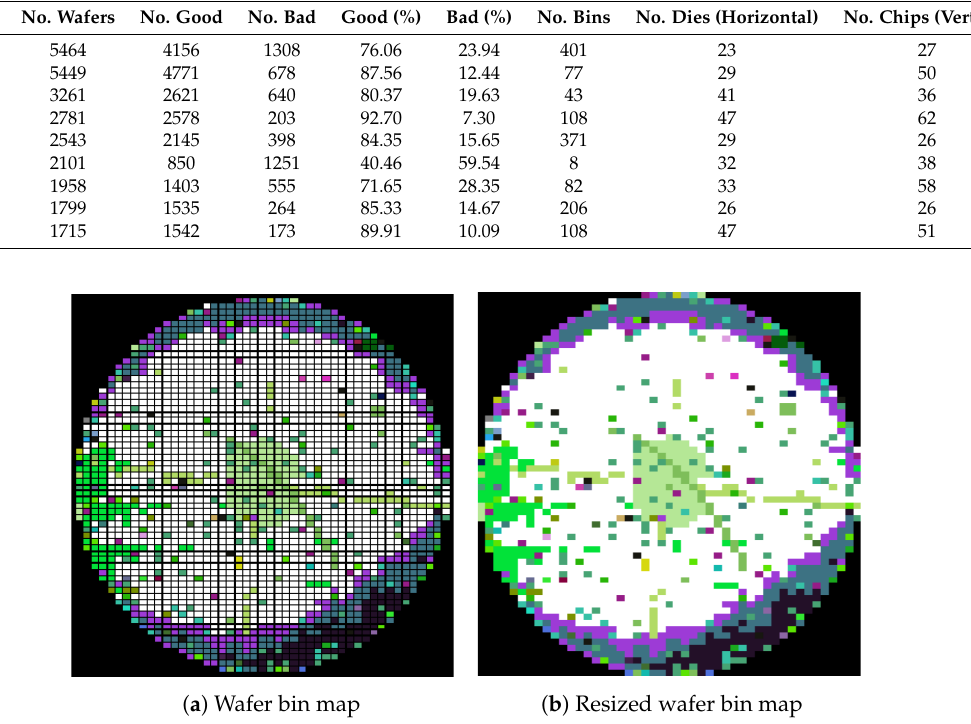
Figure 4. Example of wafer bin map and resized image from wafer chip